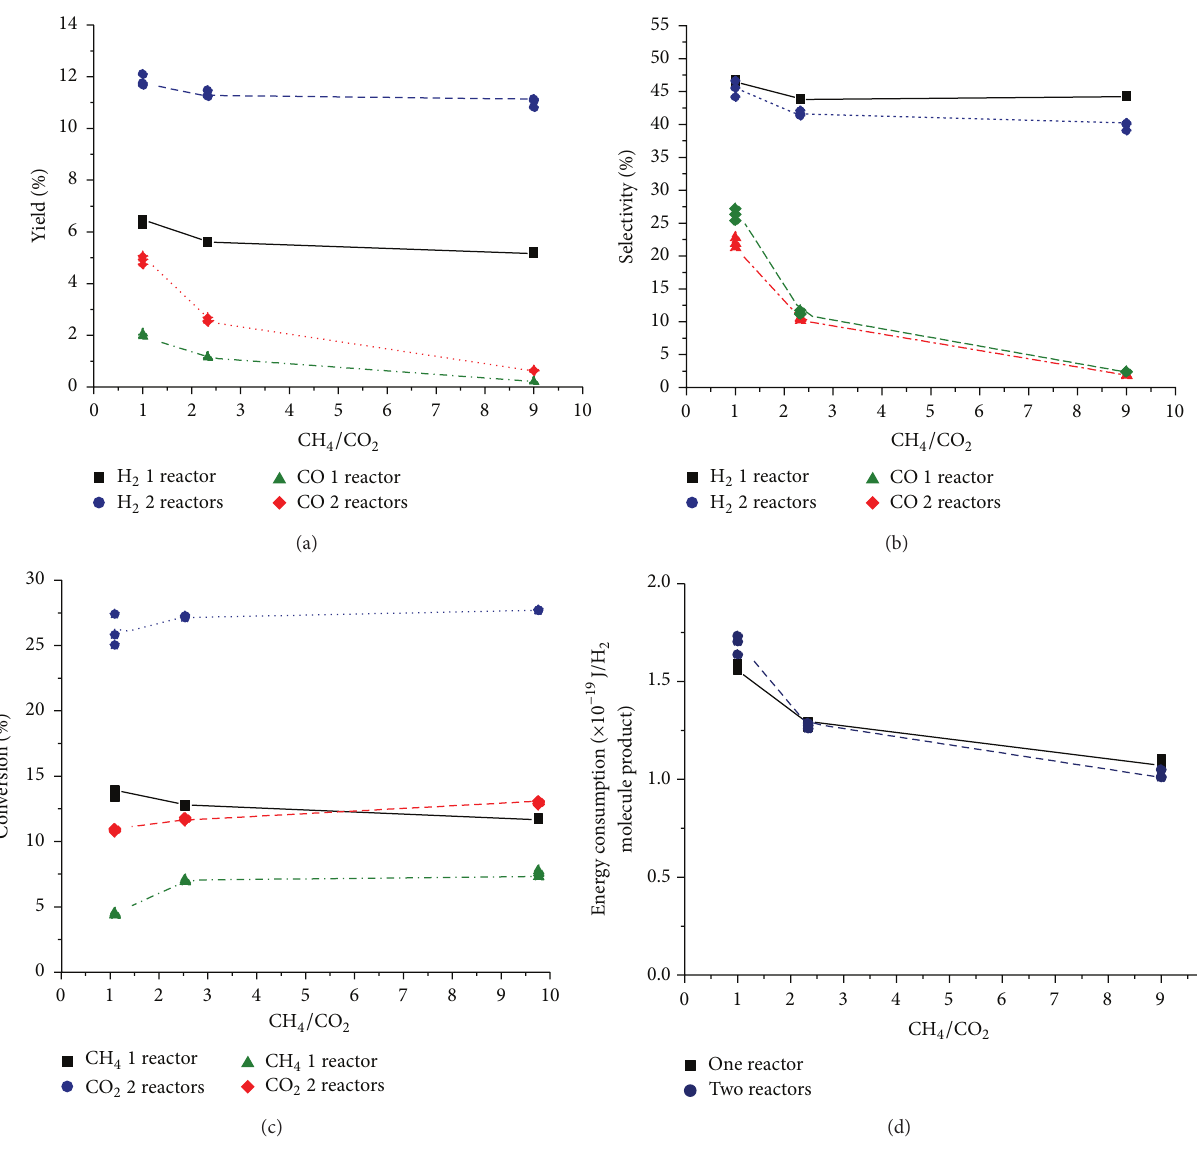
Figure 5: Effect of number of reactor on biogas reforming